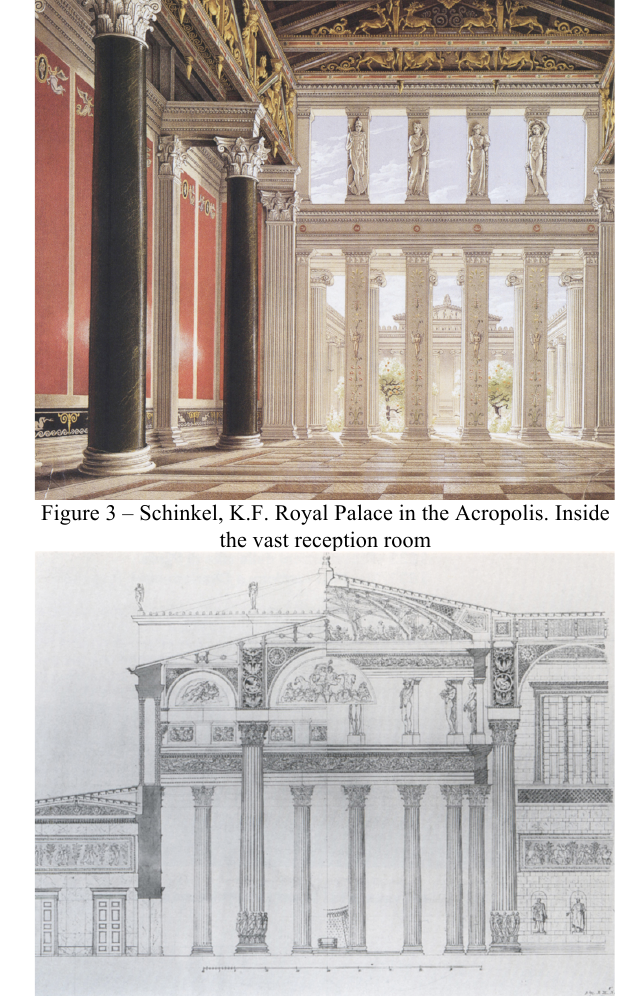
Figure 4 – Schinkel, K.F. Cross sections of the Throne Room,